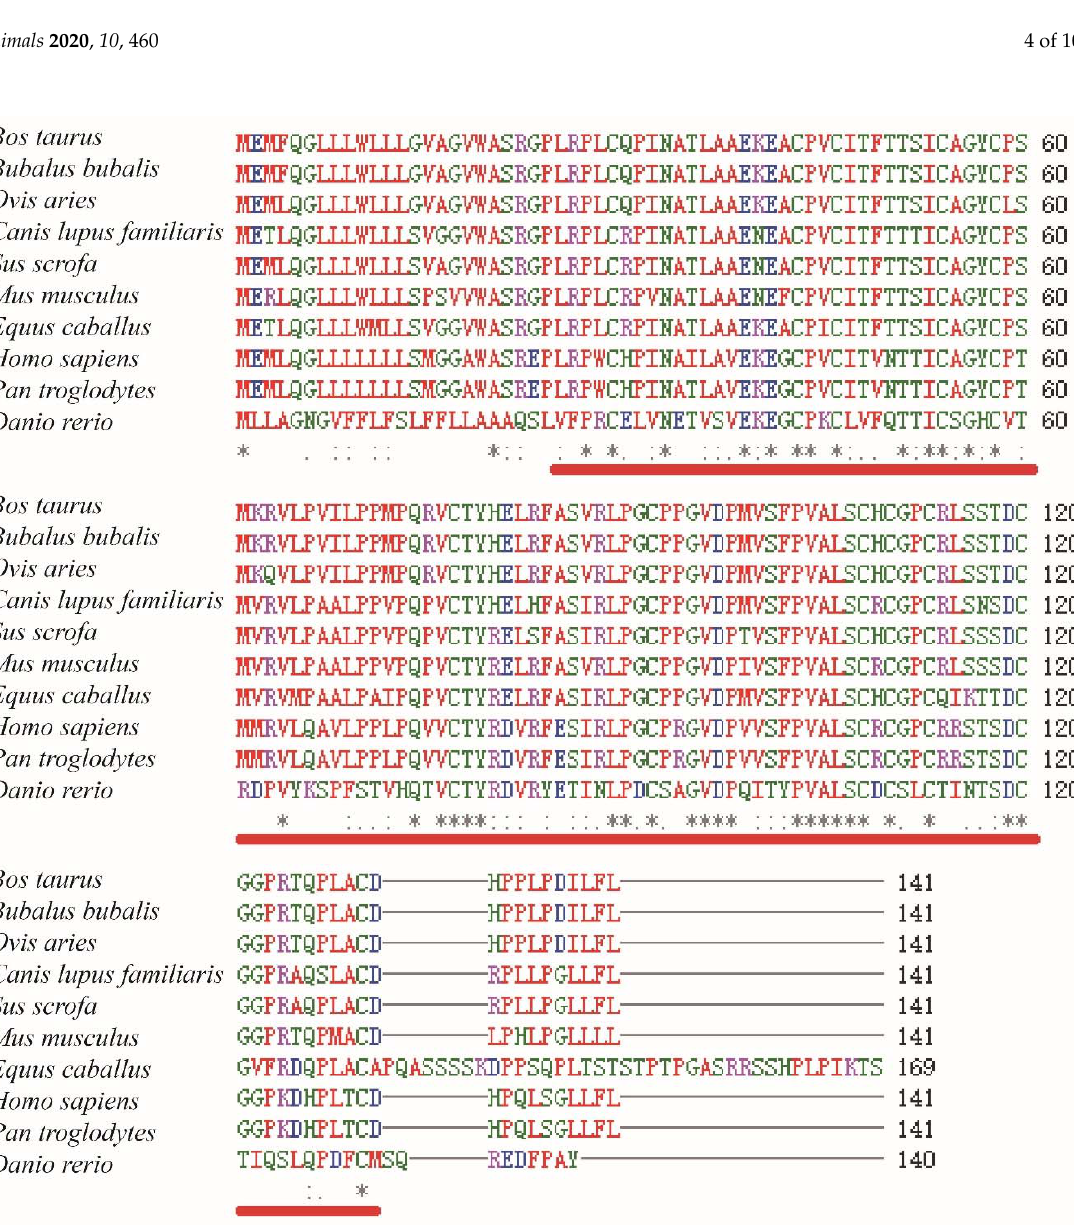
Figure 1. Multiple amino acid sequence alignments of Bos taurus (NM_173930.1), Bubalus bubalis (NM_001290957.1), Ovis aries (NM_001009380.1), Canis lupus familiaris (NM_001197033.1), Sus scrofa (XM_005664701.1), Mus musculus (NM_008497.2), Equus caballus (NM_001197093.1), Homo sapiens (NM_000894.2), Pan troglodytes (NM_001071803.1), and Danio rerio (NM_205622.2). Glycoprotein hormone beta chain (GH β ) homologues are indicated by red underlining. The same sequence is indicated by an asterisk. The conservative and semi ‐ conservative mutations are represented by “:” and “.”, respectively.